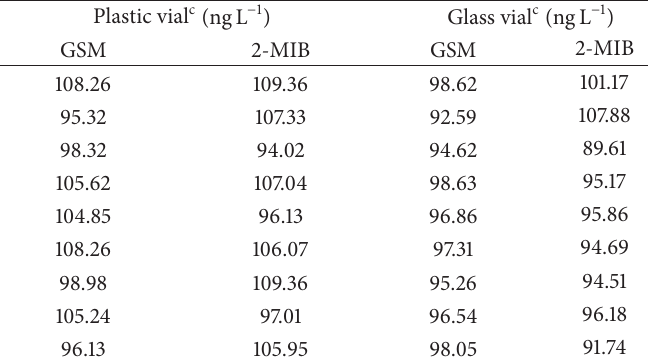
Table 5: Result a for water storage time (all samples were tested three